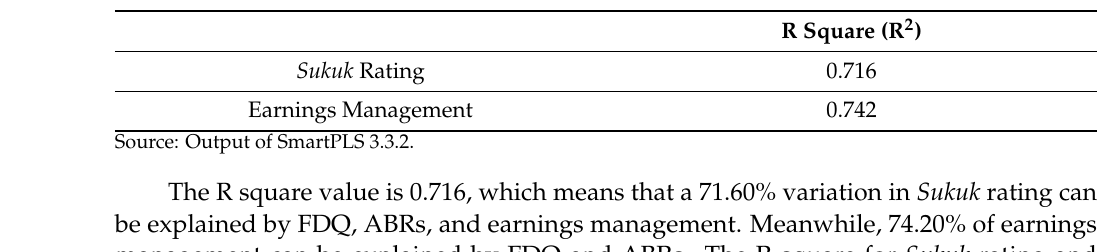
Table 7. R-Square